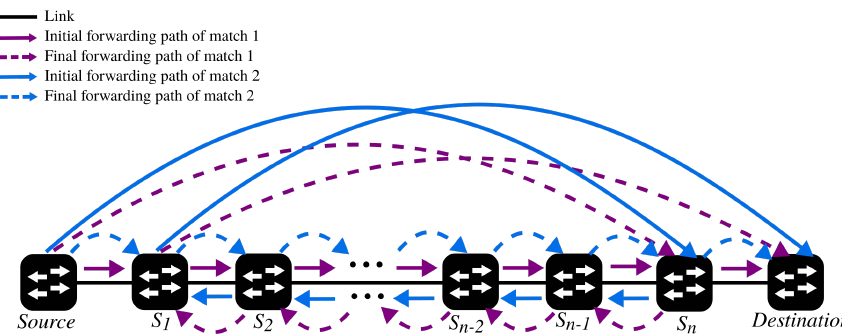
Figure 6. Two forwarding path update scenarios from the same source to the same